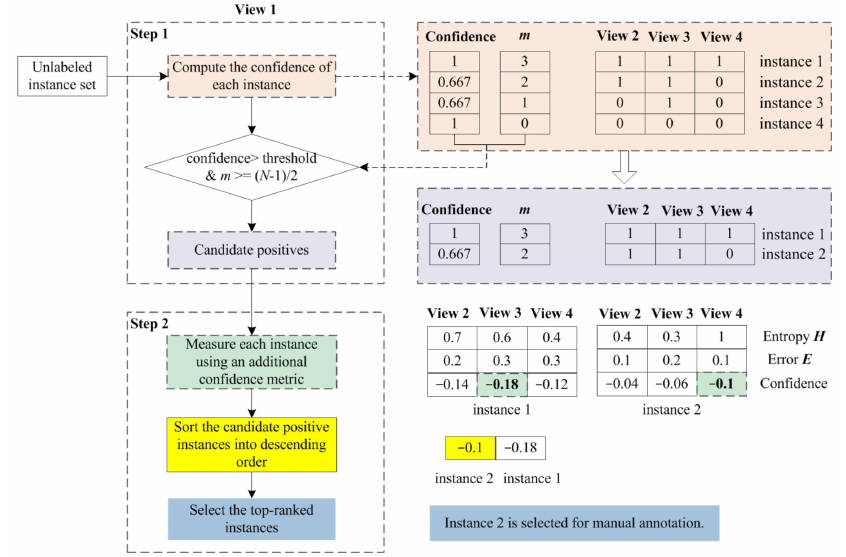
Figure 3. Illustrated example of the proposed selection strategy for potentially positive